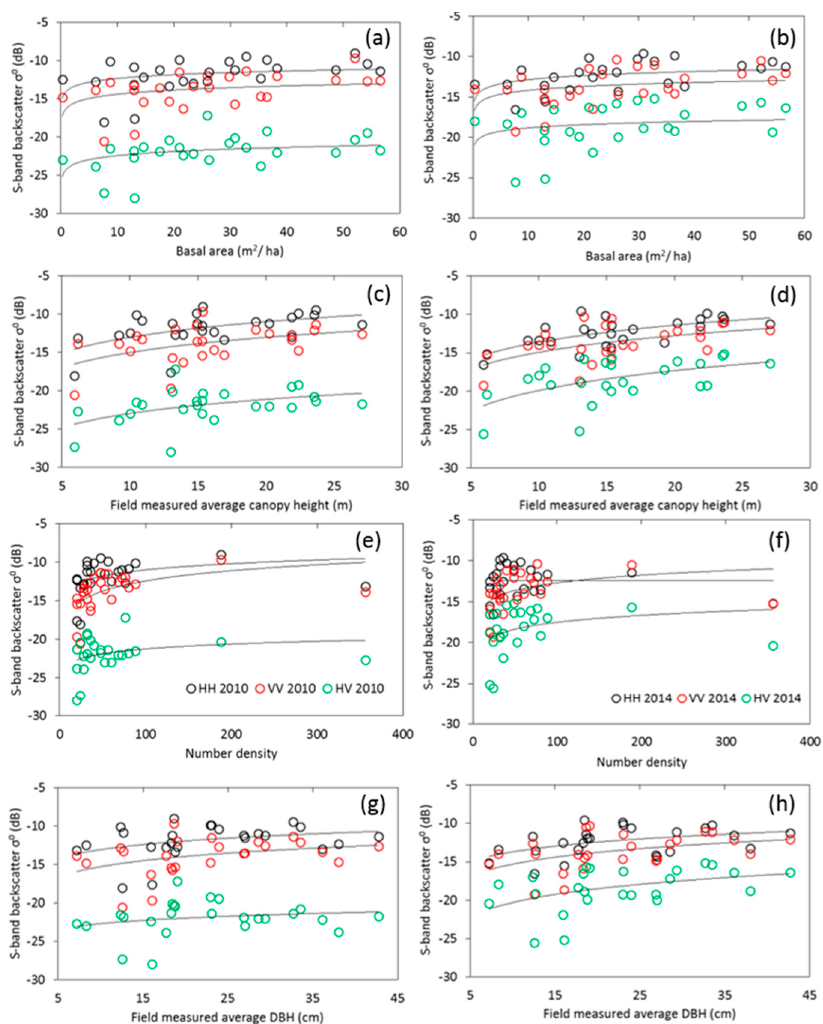
Figure 7. ( a – h ) S-band backscatter ( σ °) plotted against basal area, average canopy height, stem density and average tree diameter for ( left panel ) 2010 and 2014 ( right panel ) for combined test sites.